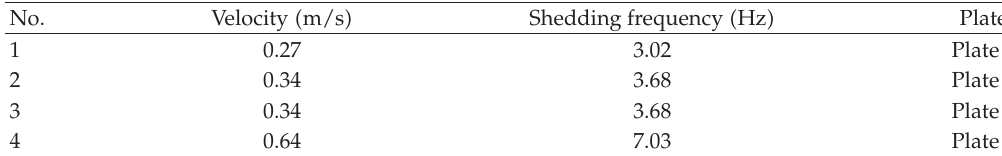
Figure 4: Simple case domain with boundary conditions. Table 1: Investigated inlet conditions and material parameters.